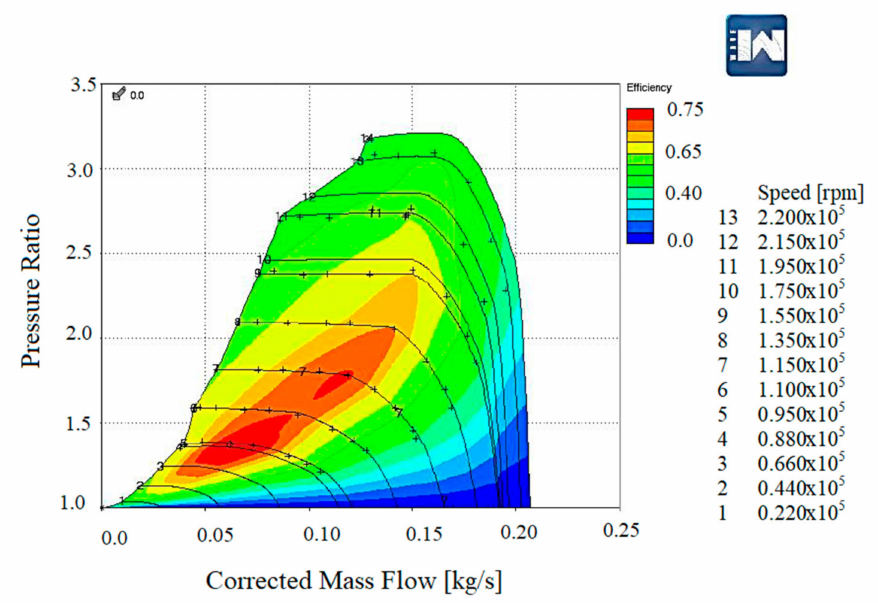
Figure 9. Scaled compressor